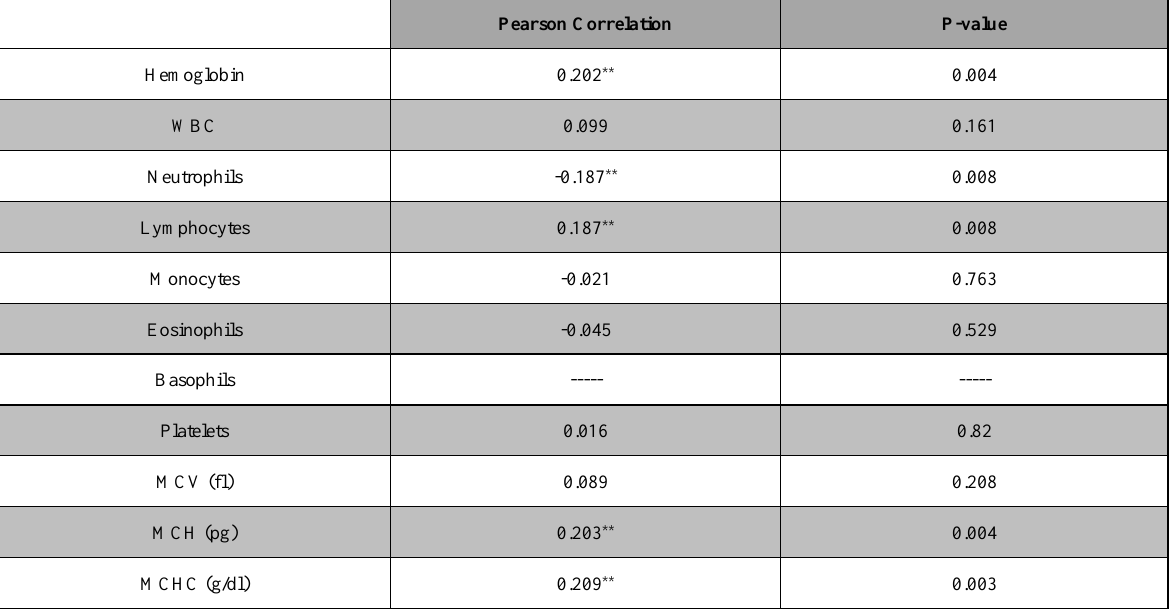
Table 4. Correlation of CD4 with various